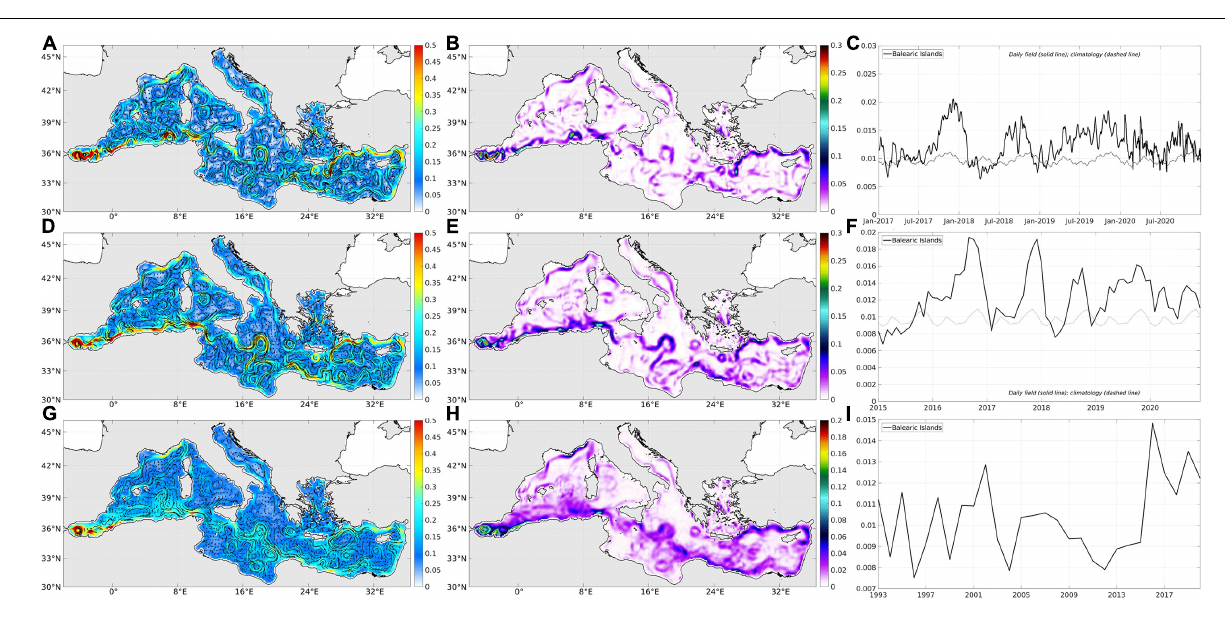
FIGURE 5 | Illustrations for GV (in m/s) and TKE (in m 2 /s 2 ): daily means on 31-December-2020 (A–C) , monthly means in December 2020 (D–F) and annual means in 2020 (G–I) : 2D maps of GV (A,D,G) and TKE (B,E,H) , and time series of TKE averaged in the Balearic Islands since 2017, 2015, and 1993, respectively (C,F,I)